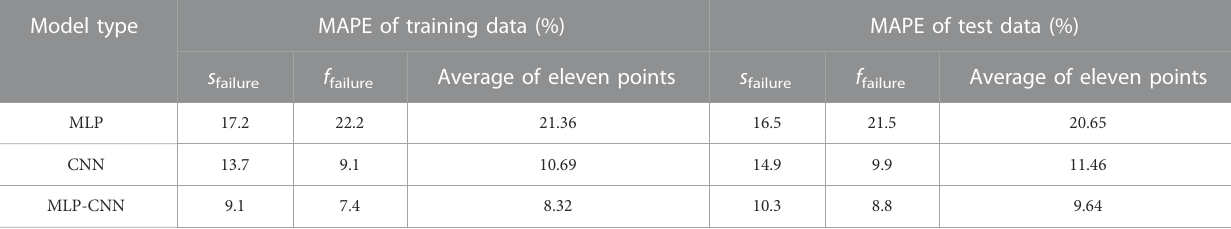
TABLE 6 MAPE of the outputs of training and test data for the three trained neural networks. Model